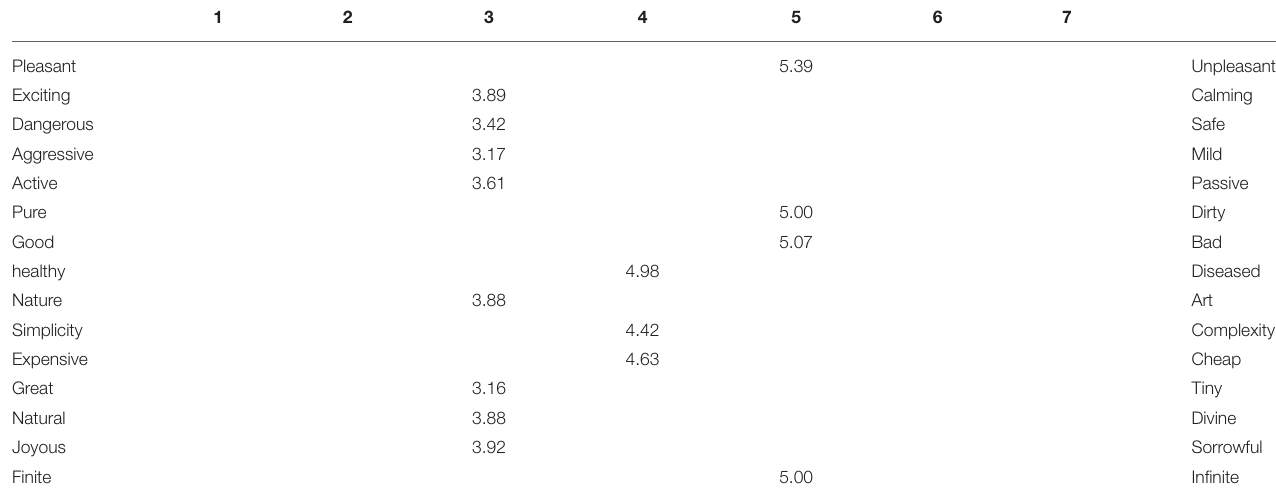
TABLE 3 | The concept of ugliness semantic difference